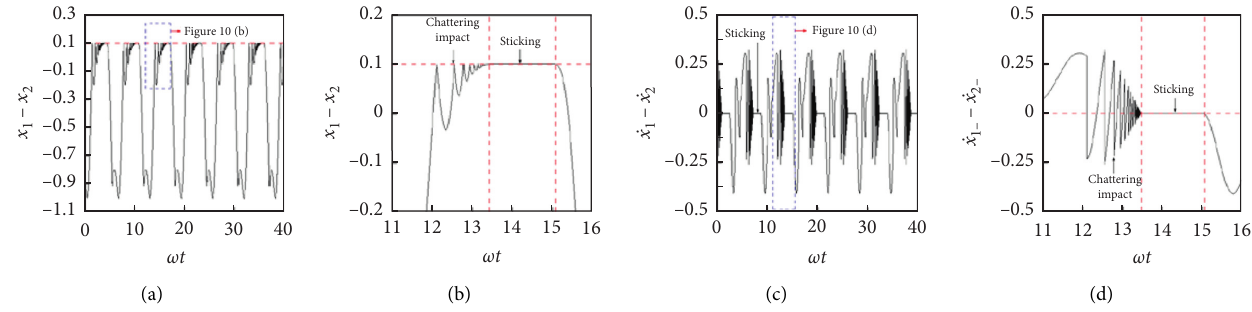
− x ; (b) local enlargement of Figure 10(a); (c) time series of 1 2